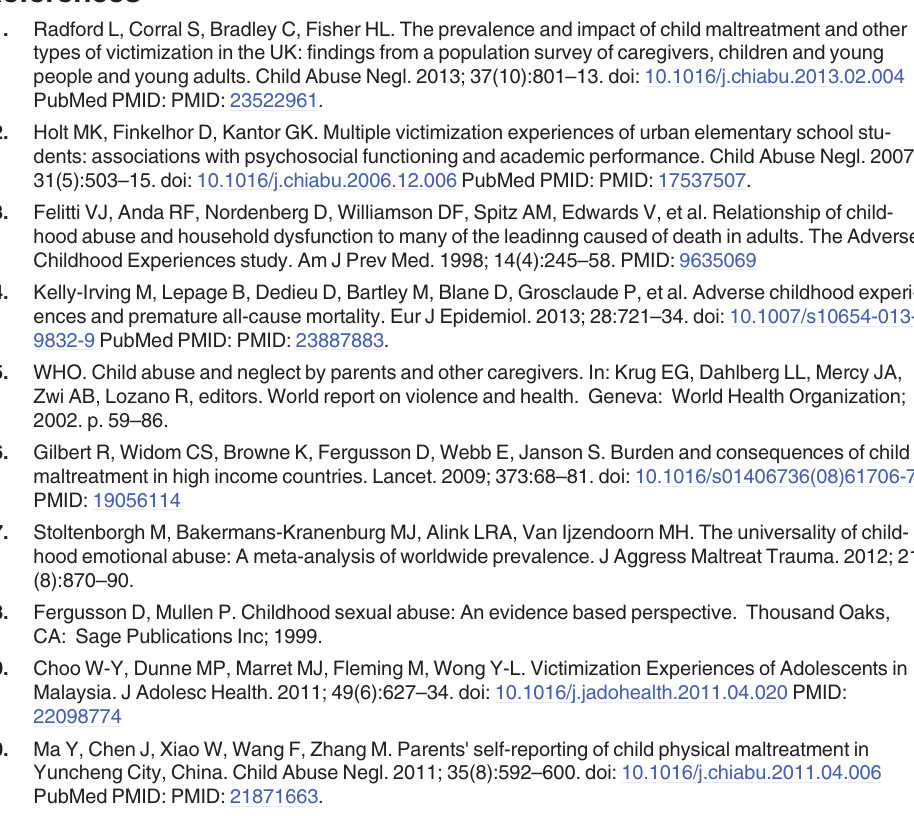
S5 Table. Item by item prevalence of Parental Neglect in both genders. S6 Table. Item by item prevalence of Teacher Inflicted Physical Maltreatment in both